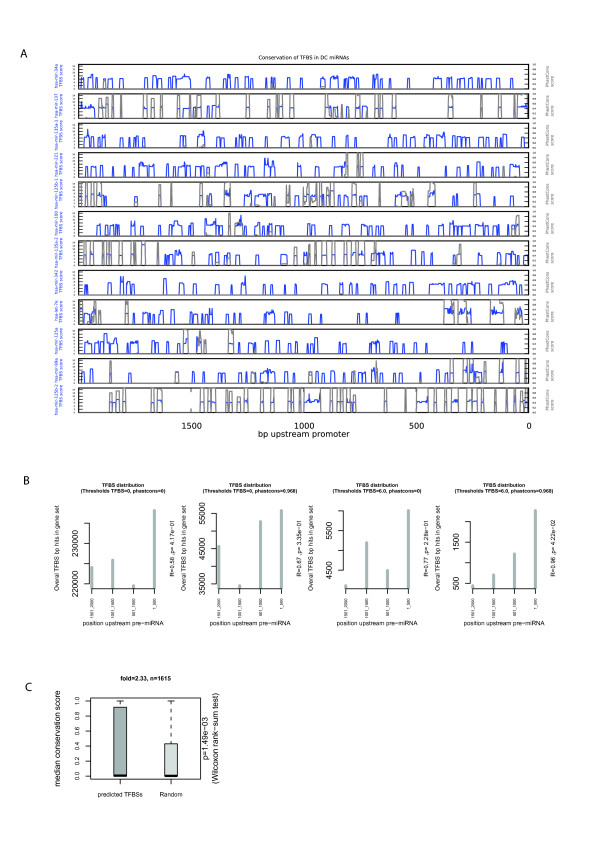
Distribution and evolutionary conservation of TFBSs in promoter regions of DC-expressed miRNAs. (A) The TFBS motif scores (in blue, y-axis range from 0 to 15 per subgraph) as calculated using Clover and the extent of evolutionary conservation as PhastCons score (in grey, y-axis on the right). (B) Distribution pattern of TFBSs, selected based on various motif score and evolutionary score thresholds, in the promoter region of miRNAs up-regulated in DCs. (C) Comparison of the median conservation scores of the bases in the predicted TFBSs in the promoters of miRNAs that are over-expressed in DCs, with those of randomly chosen sequences of the same length from the same promoters. Boxplots represent the median and interquartile range of the median PhastCons conservation scores. The fold shown is the ratio of the median of the DC conservation scores and the median of the conservation scores of the random sets (n = number of TFBS instances concerned).